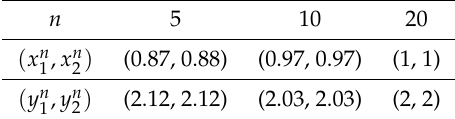
Table 19. Values of the iterated sequence ( x n , y n ) if started with (( 0.01,0.2 ) , ( 2.9,2.1 ))